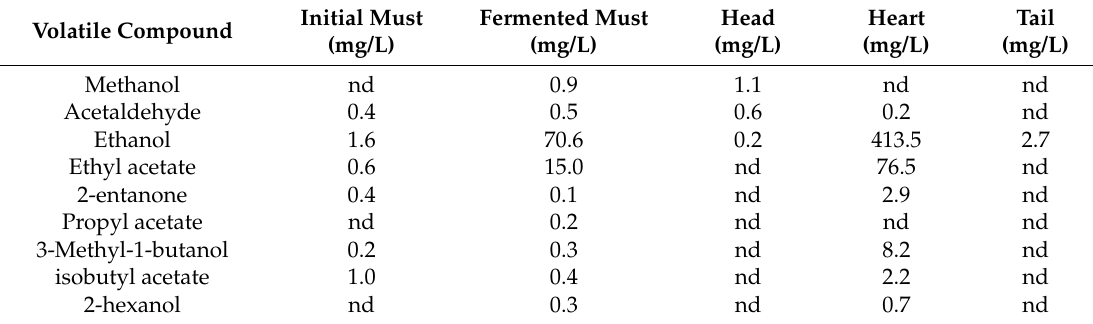
Table 3. Volatile compounds identified in the headspace during different stages of the process to obtain banana brandy fermented by Pichia kluyveri